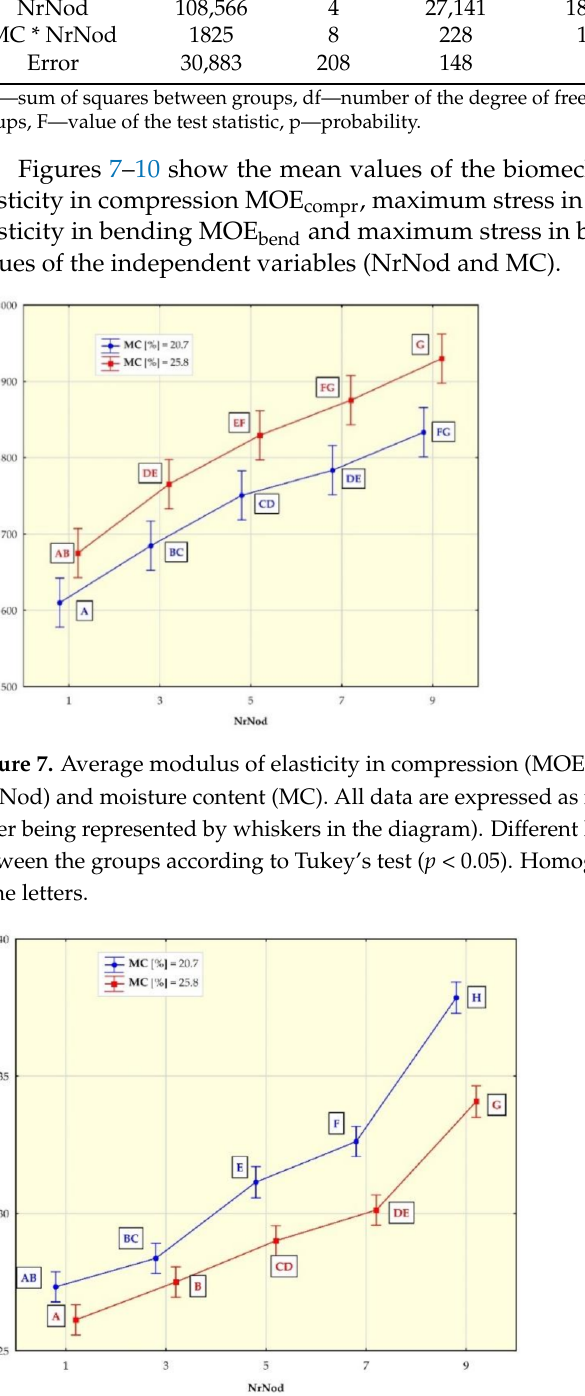
Figure 8. Average maximum stress in compression ( σ comp ) values for different internodes (NrNod) and moisture content (MC). All data are expressed as mean ± 95% confidence interval (the latter being represented by whiskers in the diagram). Different letters indicate significant differences between the groups according to Tukey’s test ( p < 0.05). Homogeneous groups are marked with the same